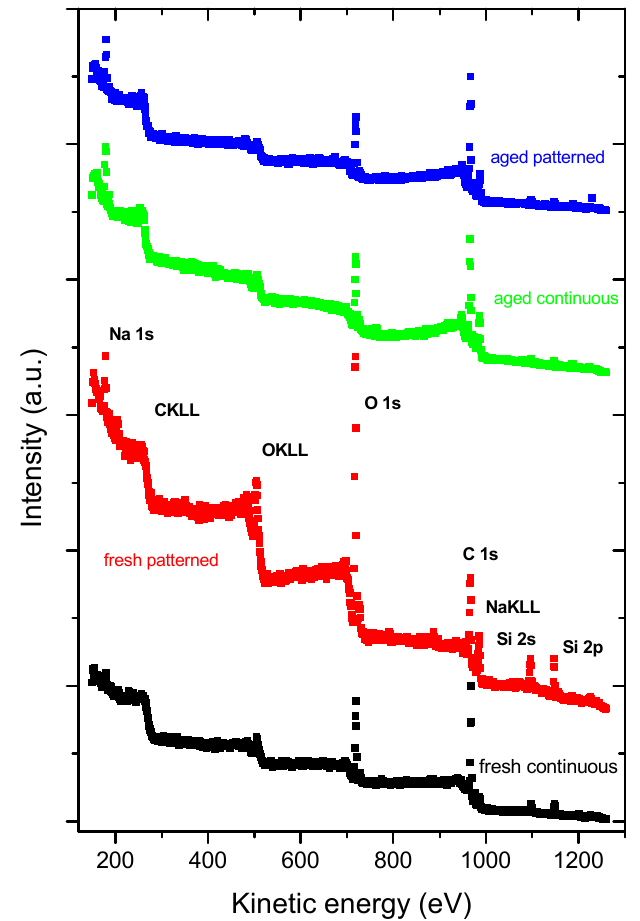
Figure 4. Survey XPS spectra of samples under analysis. C 1s, O 1s Si 2s, Si 2p and Na 1s are core-level photoelectron spectra from carbon, oxygen, silicon and sodium